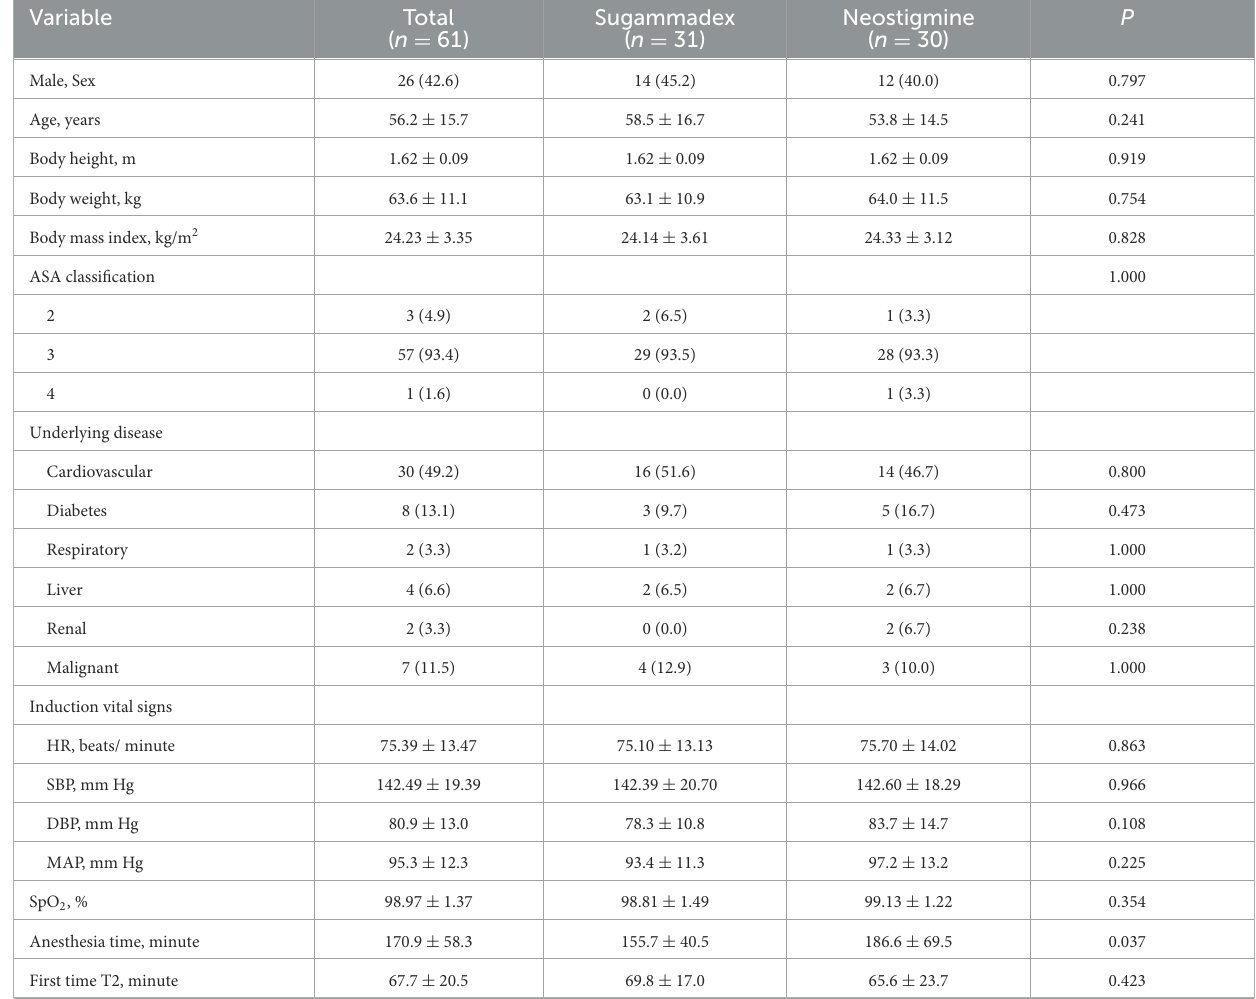
TABLE 1 Clinical characteristics of patients in the sugammadex and neostigmine groups.